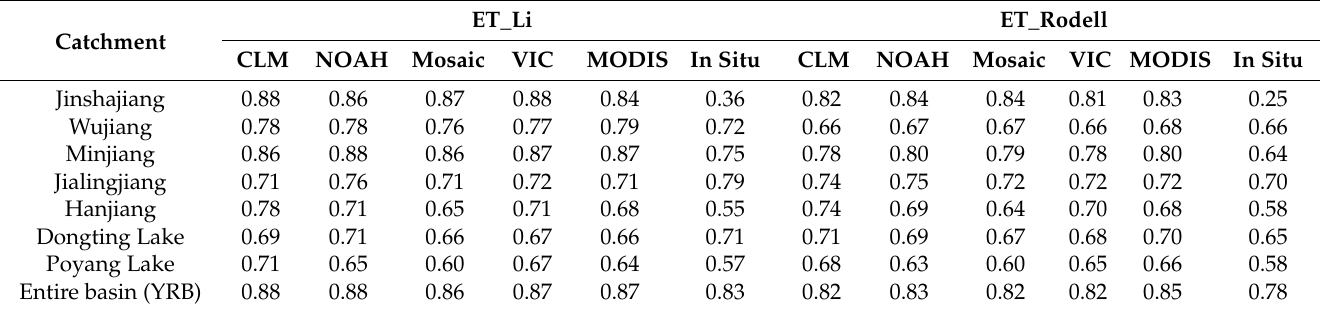
Table 4. The correlation coefficients ( R 2 ) between ET estimation results (ET_Li and ET_Rodell) and ET from different products. ET_Li ET_Rodell Catchment CLM NOAH